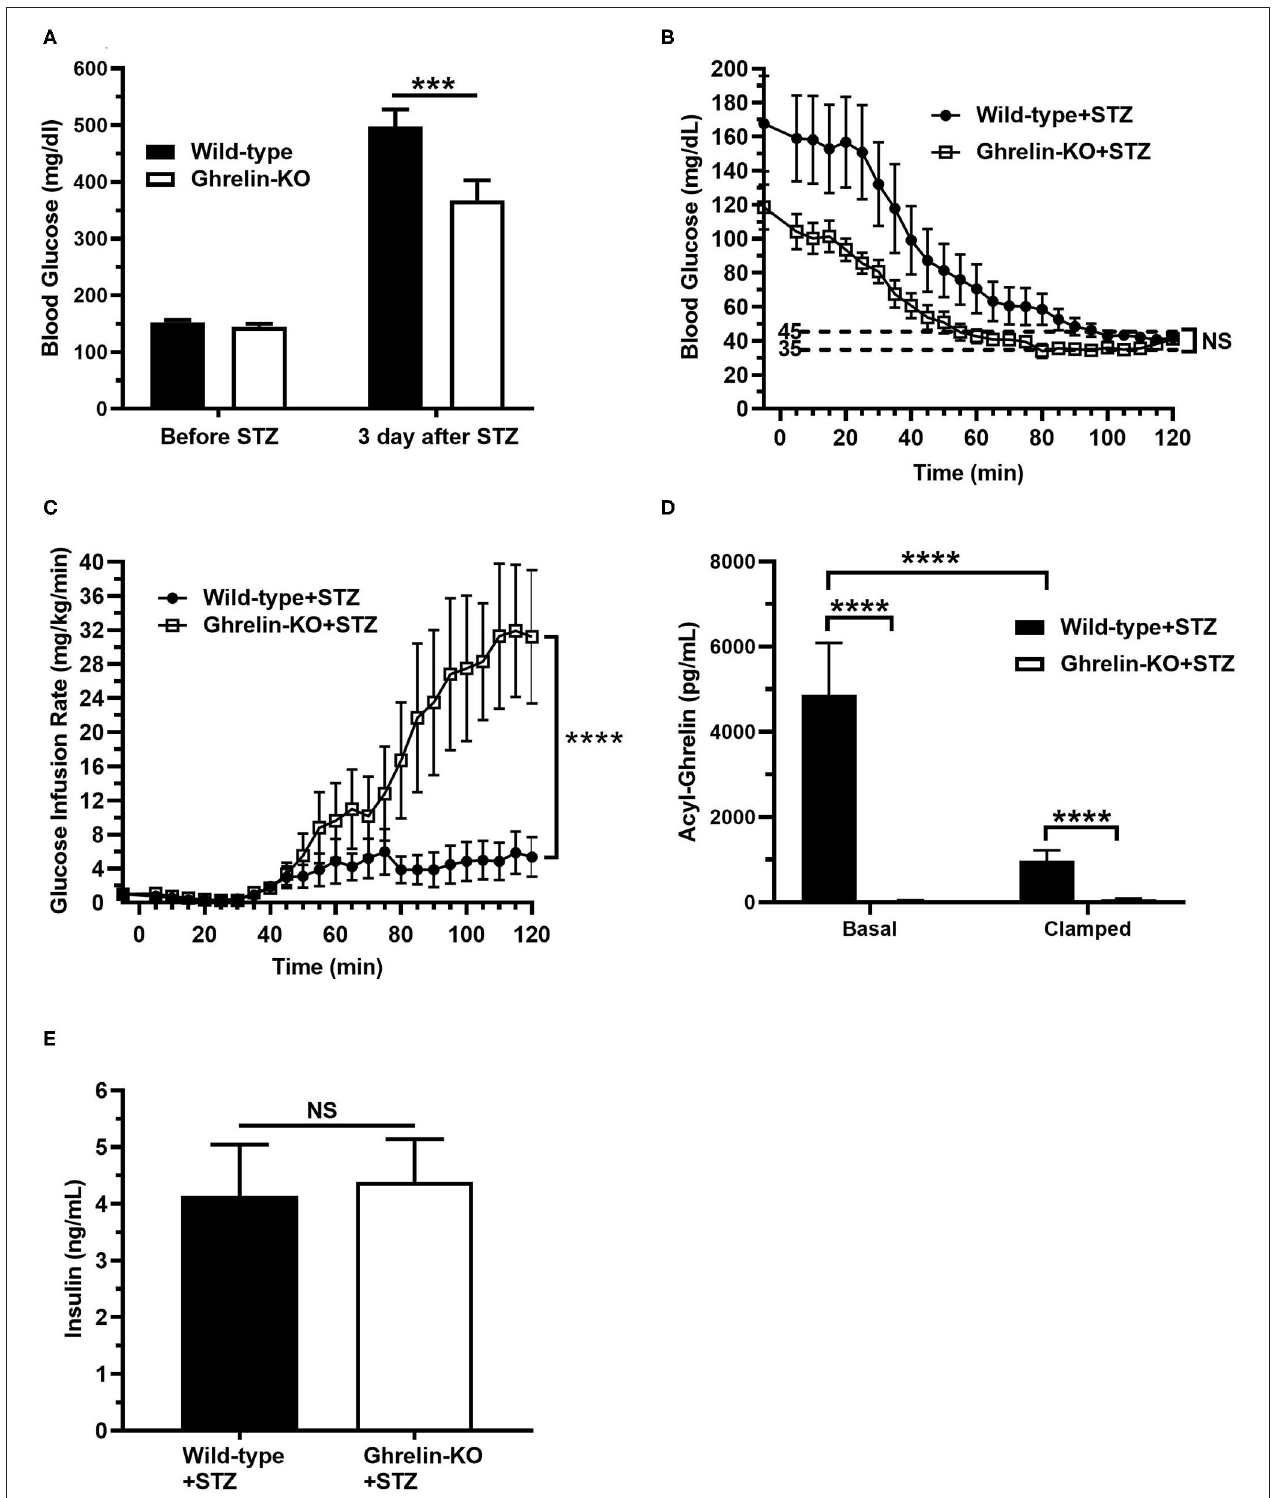
FIGURE 2 | Low-dose hyperinsulinemic–hypoglycemic clamps in STZ-treated mice. (A) Ad lib -fed blood glucose levels before and 3 d after STZ administration. (B) Blood glucose levels during the clamps. (C) Glucose infusion rate (GIR) to achieve the target blood glucose (35–45 mg/dL) by the steady-state period (100–120min) in mice receiving Humulin-R insulin (4 mU/kg/min) from 0 to 120min. (D) Plasma ghrelin levels at the start (“Basal”; t = − 5min) and end (“Clamp”; t = 120min) of the clamps. (E) Plasma insulin levels at the end (“Clamp”; t = 120min) of the clamps. n = 10–11. Data are presented as mean ± SEM. *** P < 0.001, **** P < 0.0001, NS, no significant